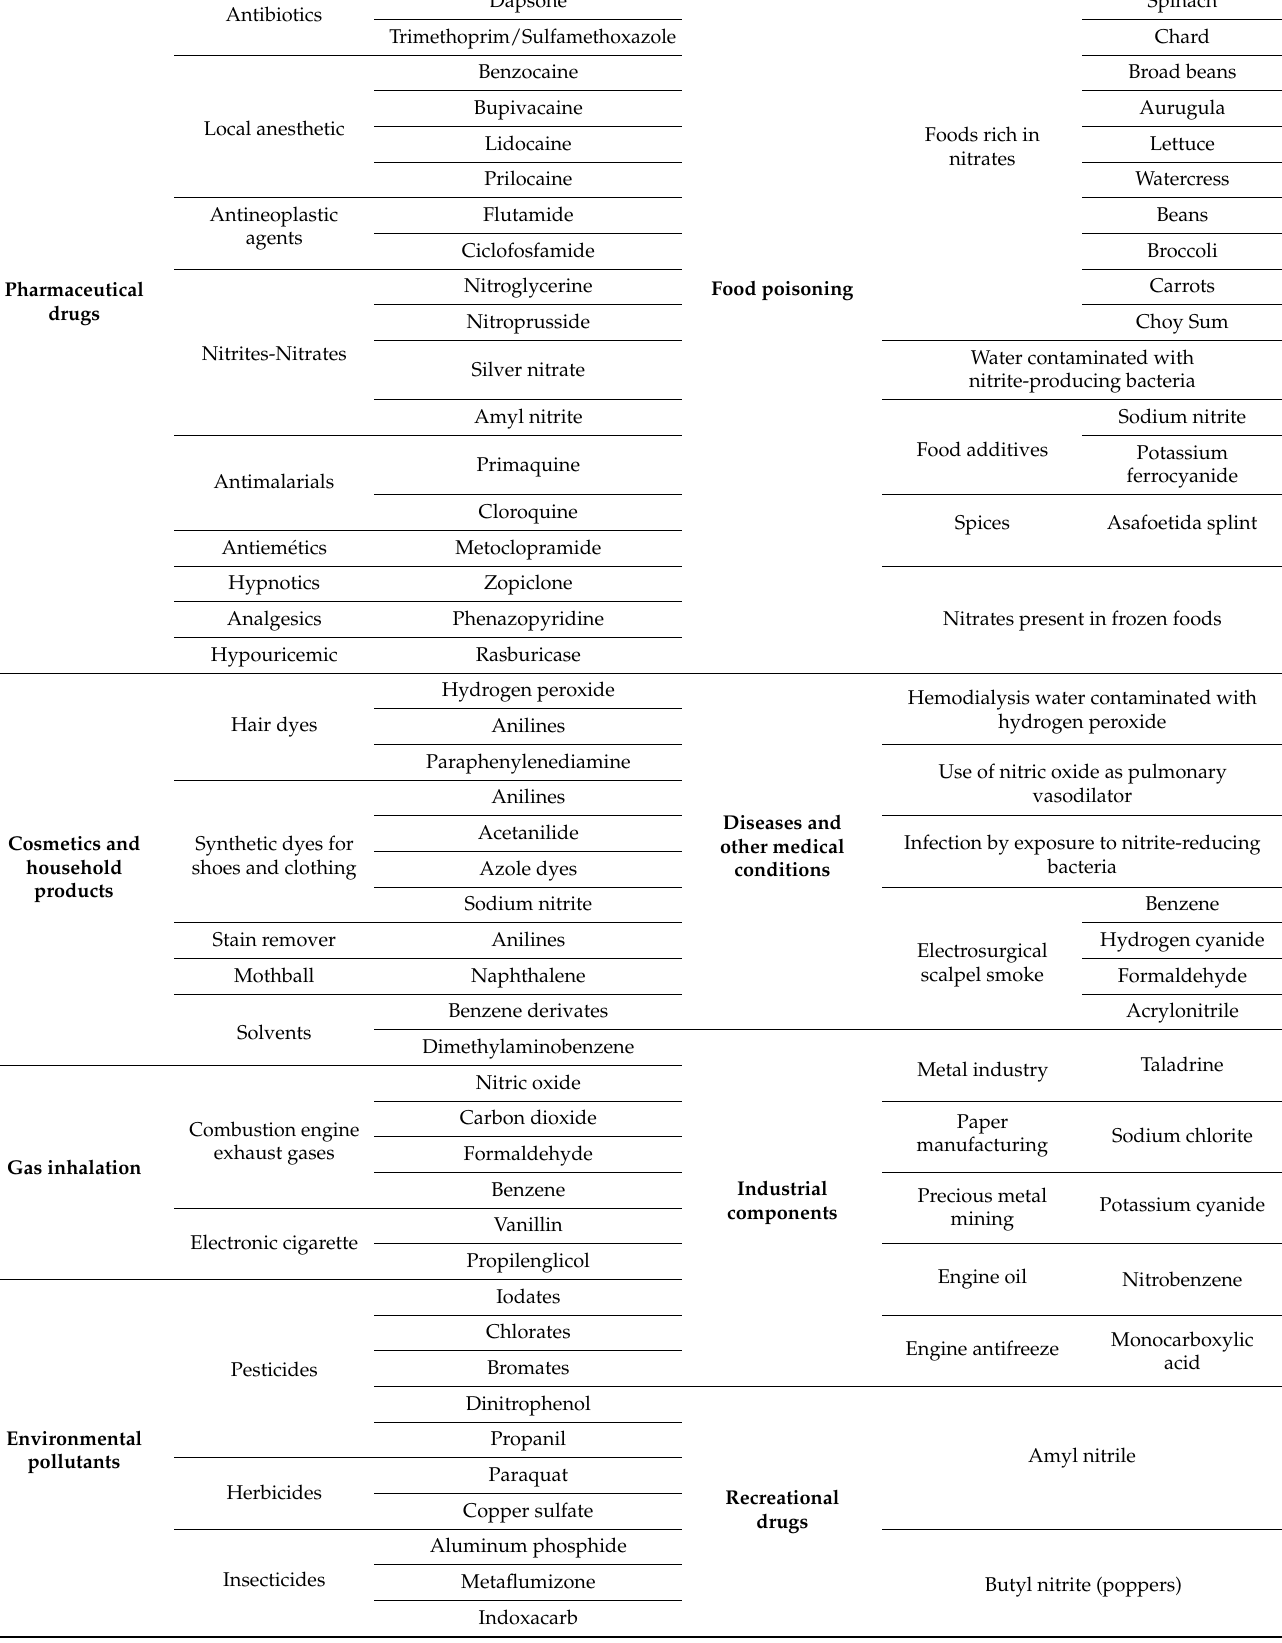
Table 1. Causes of acquired